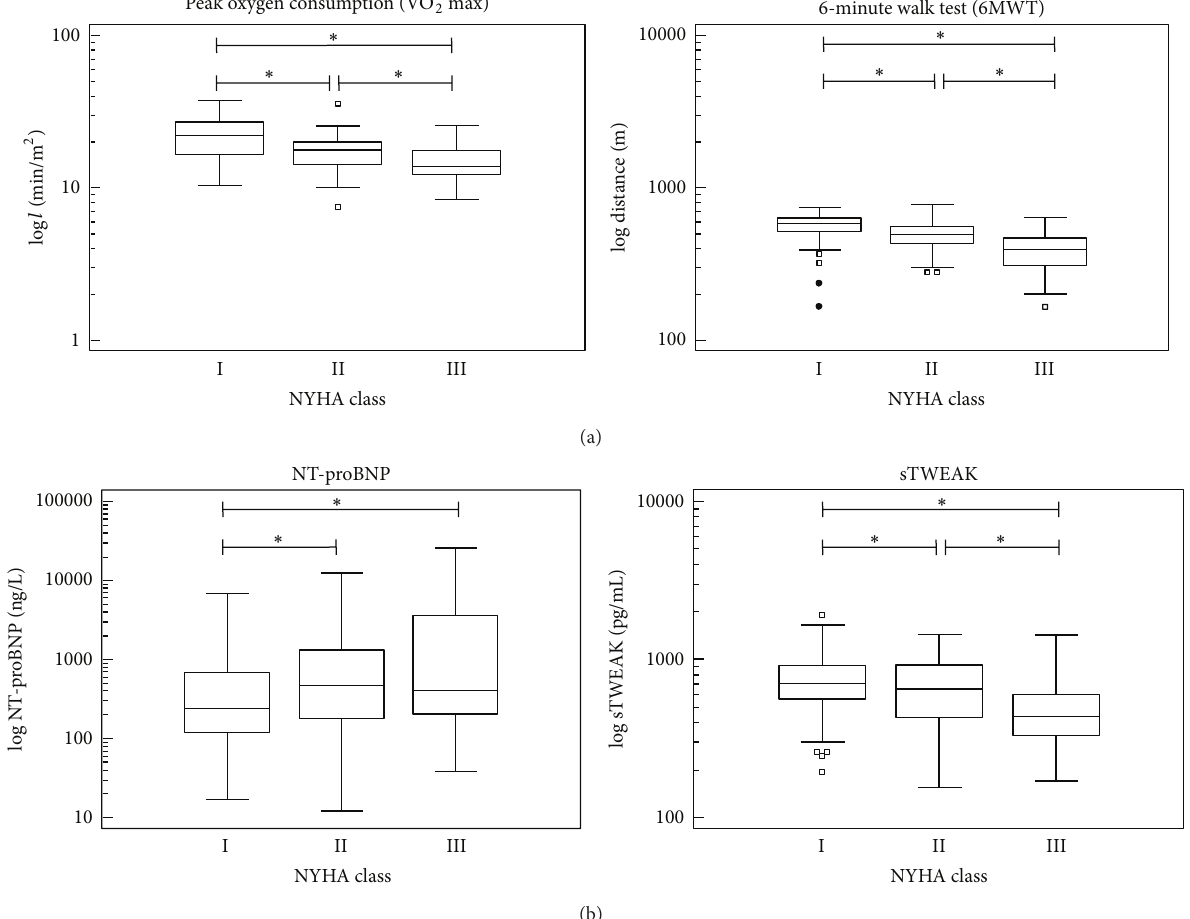
Figure 1: In our patient cohort of stablepatients with dilated cardiomyopathy, reported functional NYHA class correlated well with functional testing. With increasing NYHA class, peak oxygen consumption (VO 2 max) and walking distance in the 6-minute walk test (6 MWT) progressivelydeclined(a),whereasNT-proBNPlevelsincreased(b).Incontrast,sTWEAKlevelssignificantlydeclinedwithincreasingNYHA class (b). (Box-Whisker-Plots; ∗ 𝑃 < 0.05